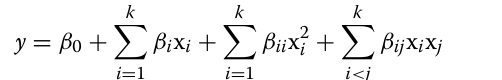
Table 1 Effects of metal ions with different concentrations on the spore yields of B. amyloliquefaciens BS-20 detected by the fluorometric assay Concentration